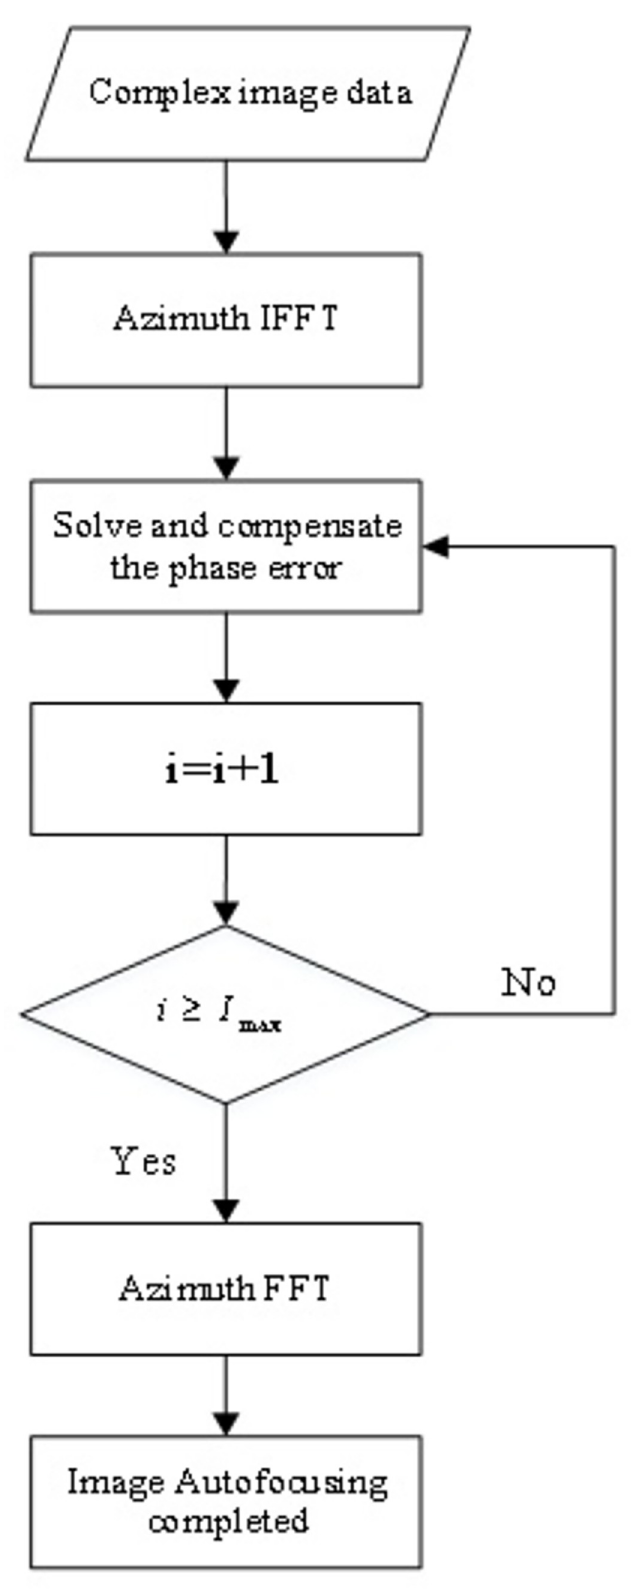
Fig 1. The flow chart of MEA